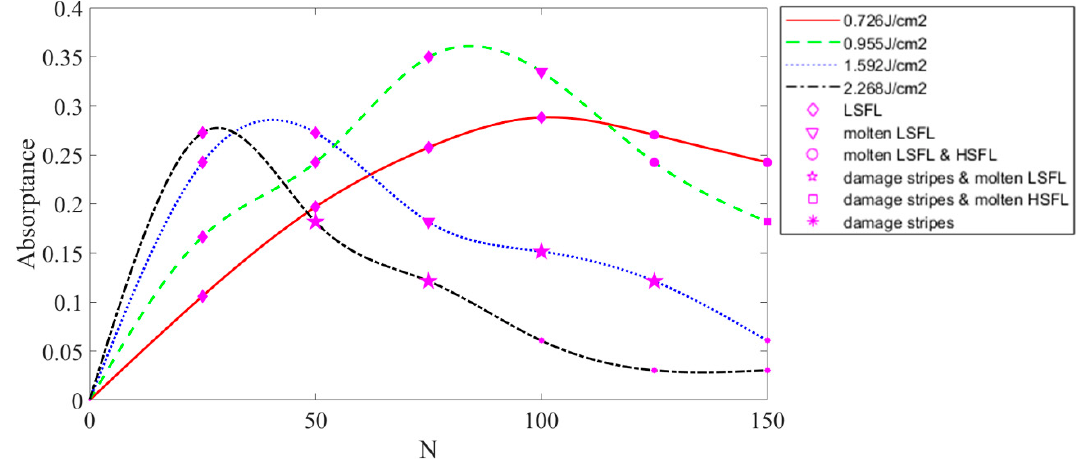
Figure 7. The relative absorptivity of samples.